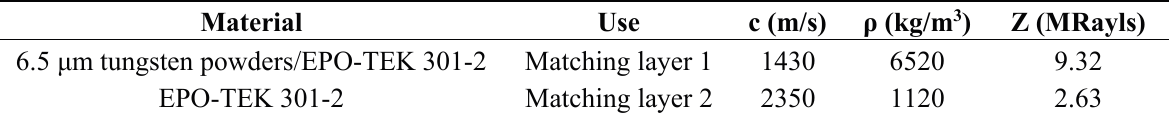
Table 2. Properties of the fabricated passive materials used in the TCD transducer.